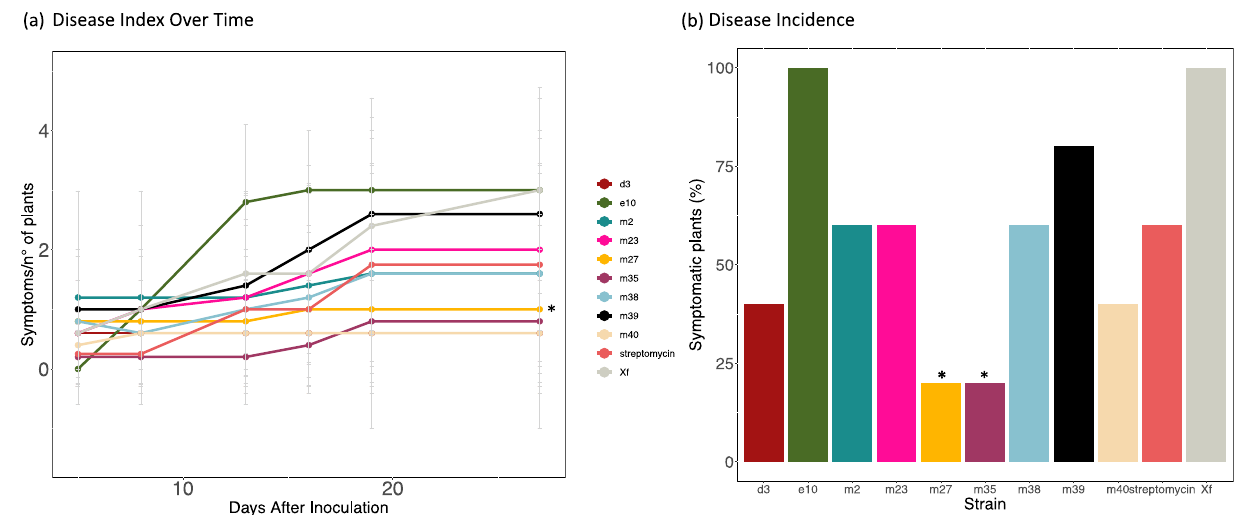
Figure 4. Effect of bacterial inoculation on X. fragariae -infected strawberry leaves, expressed as ( a ) disease index over time or ( b ) incidence (analyzed at 27 DAI). Asterisk indicates a significant difference ( p < 0.05; n = 5) from the control according to Tukey’s pairwise test (panel a ) or Fisher’s exact test (panel b